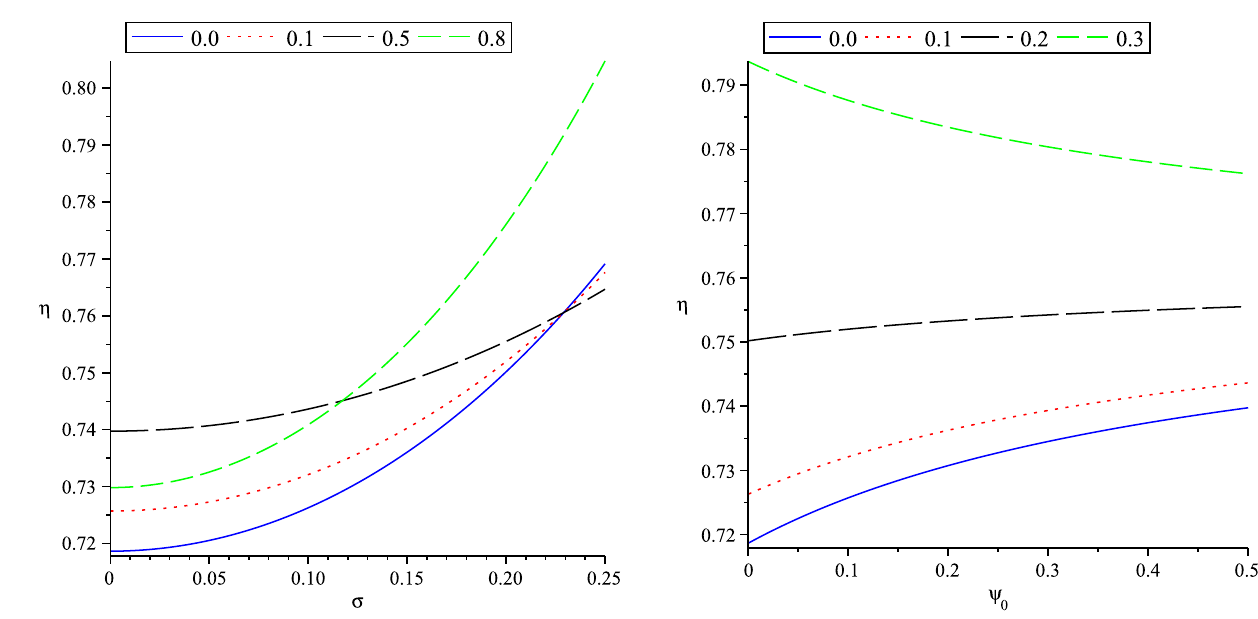
Fig. 10 Efficiency of the squared cycle as a function of the parameter ψ ( R ) gravity, for several values of the parameter 0 , related to f